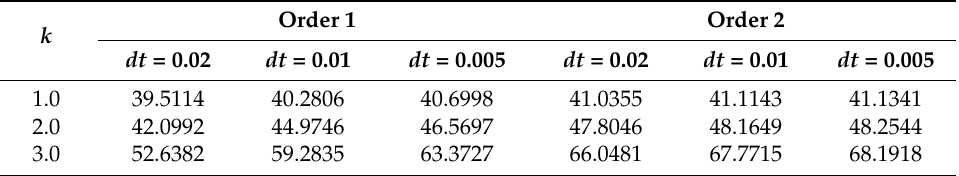
Table 1. Values of Ra for different timesteps and for the two timestepping methods.